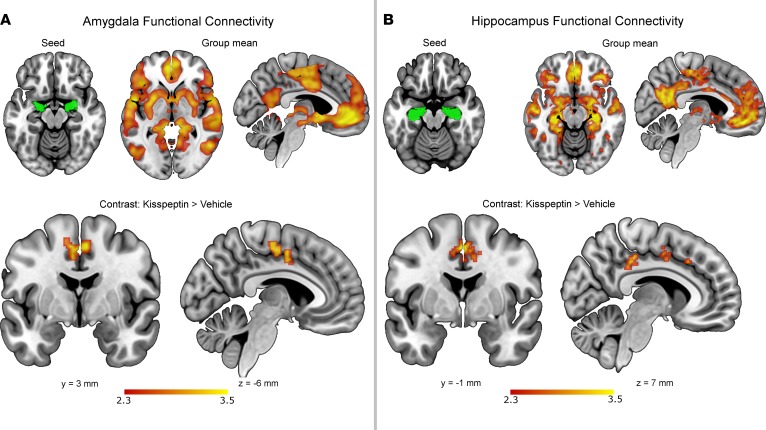
Kisspeptin enhances resting amygdala-cingulate and hippocampus-cingulate global connectivity.(A) Employing the amygdala as an anatomically defined seed region (in green) identified increased resting connectivity with the cingulate during kisspeptin administration compared with vehicle. (B) Employing the hippocampus as an anatomically defined seed region (in green) identified increased resting connectivity with the cingulate during kisspeptin administration compared with vehicle. Group means for kisspeptin and placebo visits also shown. Whole-brain voxel-wise analyses with cluster correction (Z > 2.3, P < 0.05). n = 29 per group.